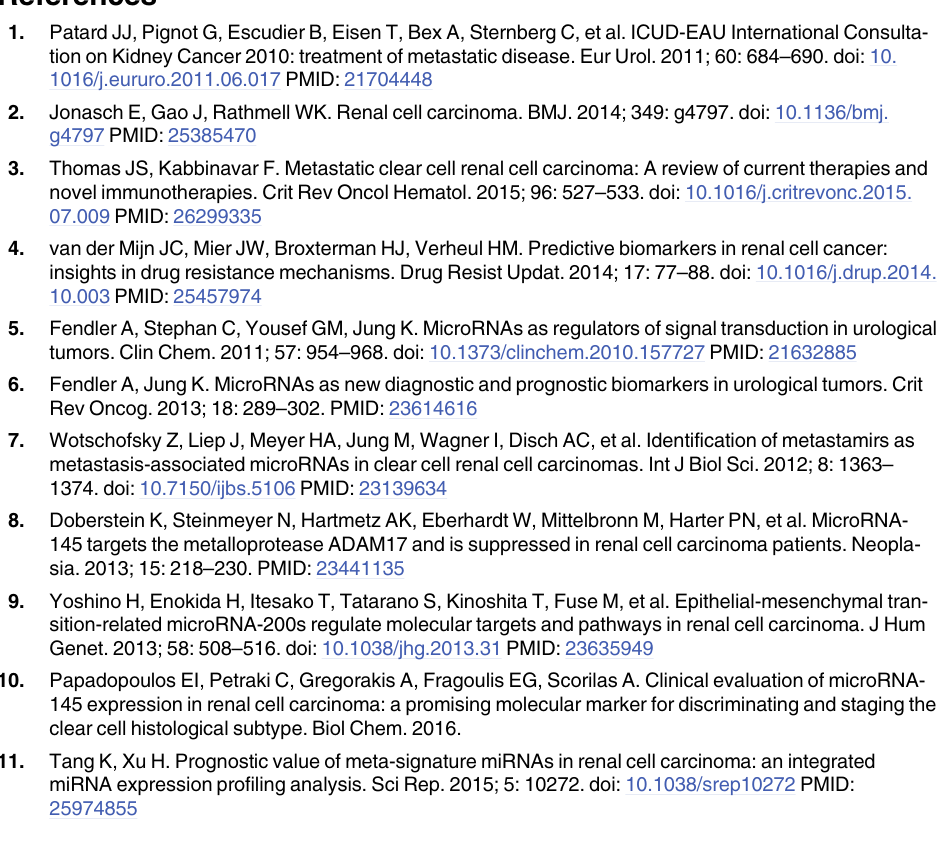
S6 Fig. Kaplan – Meier analysis of overall survival of ccRCC patients after nephrectomy depending on LOX expression. Log rank test. S1 Table. Assay information for RT-qPCR. S2 Table. Assay information for RT-qPCR. S3 Table. Synthetic miRNAs. S4 Table. Predicted targets for miR-141-3p and miR-145-5p. S5 Table. Univariate und multivariate Cox regression for ccRCC patients (pN0M0 only) (n =